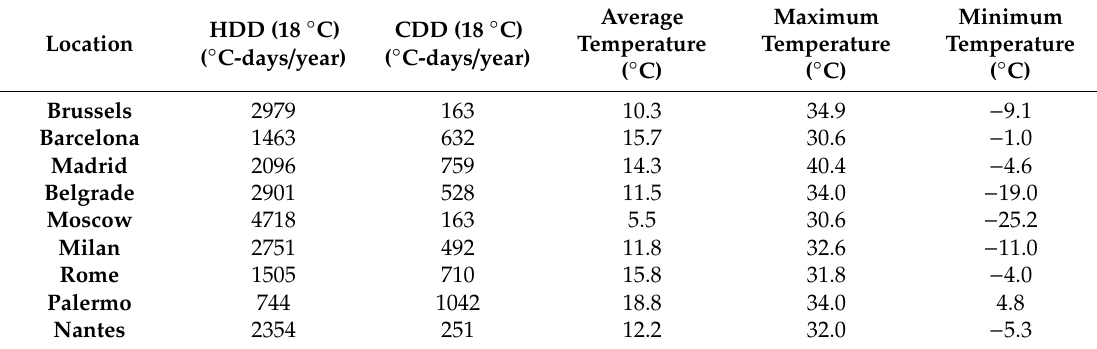
Table 12. Selected European locations, with their respective degree-day data and maximum, minimum and yearly average